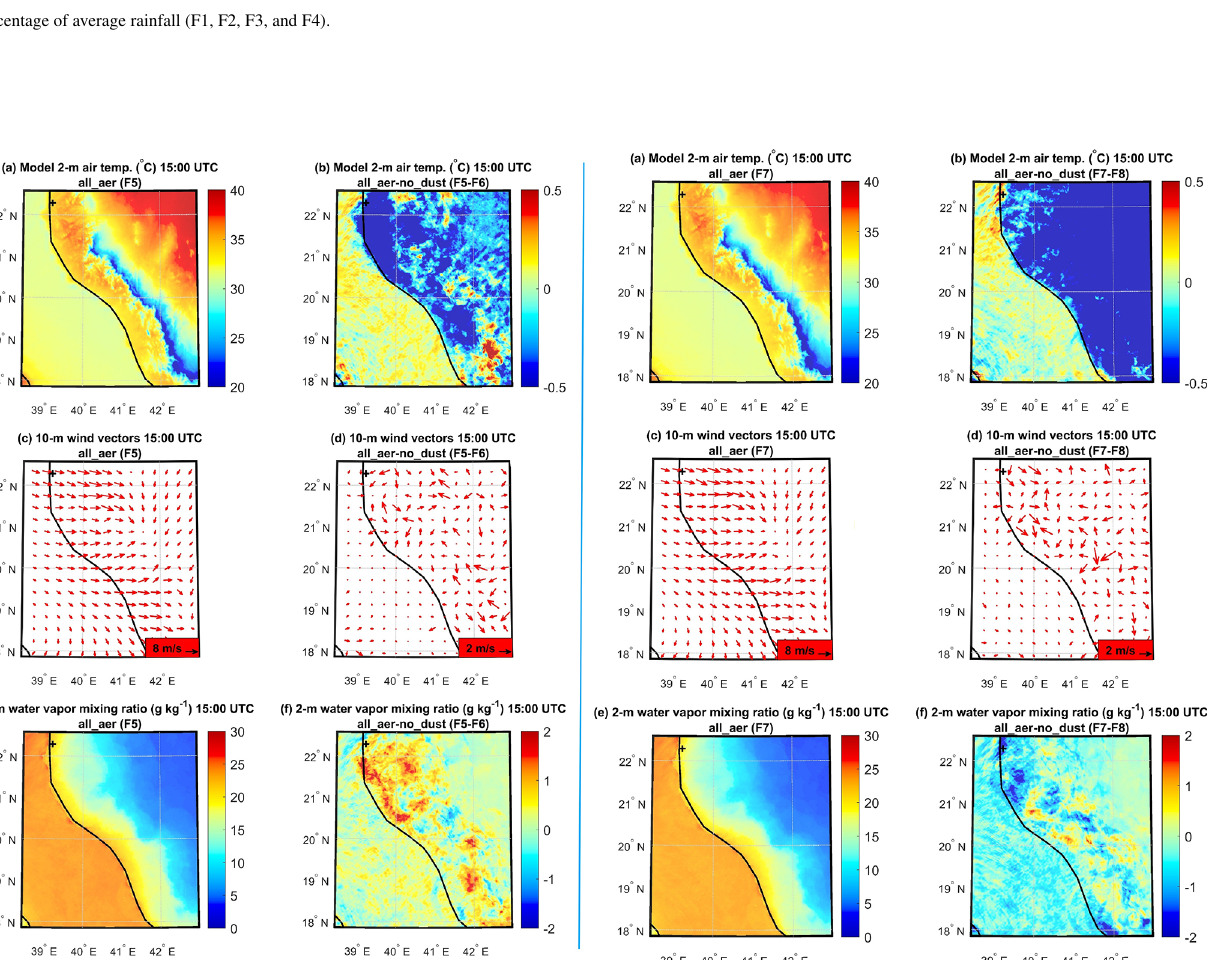
https://doi.org/10.5194/acp-22-8659-2022 Atmos. Chem. Phys., 22, 8659–8682,